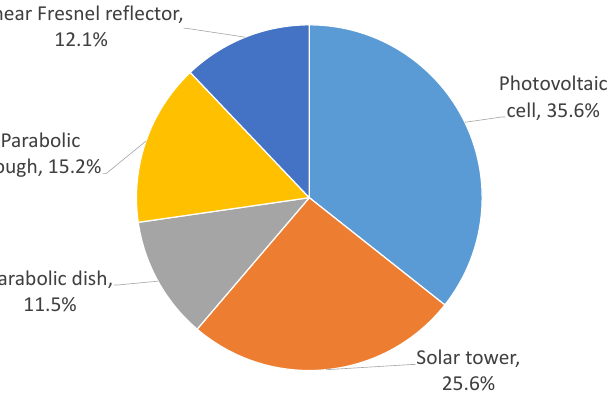
Figure 4. Distribution of different technologies in ORC applications for solar energy